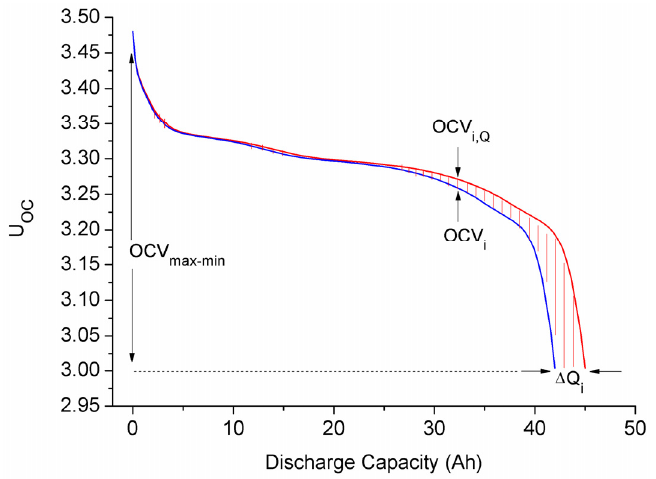
Figure 5. Effect of capacity inconsistency on U OC ( U T